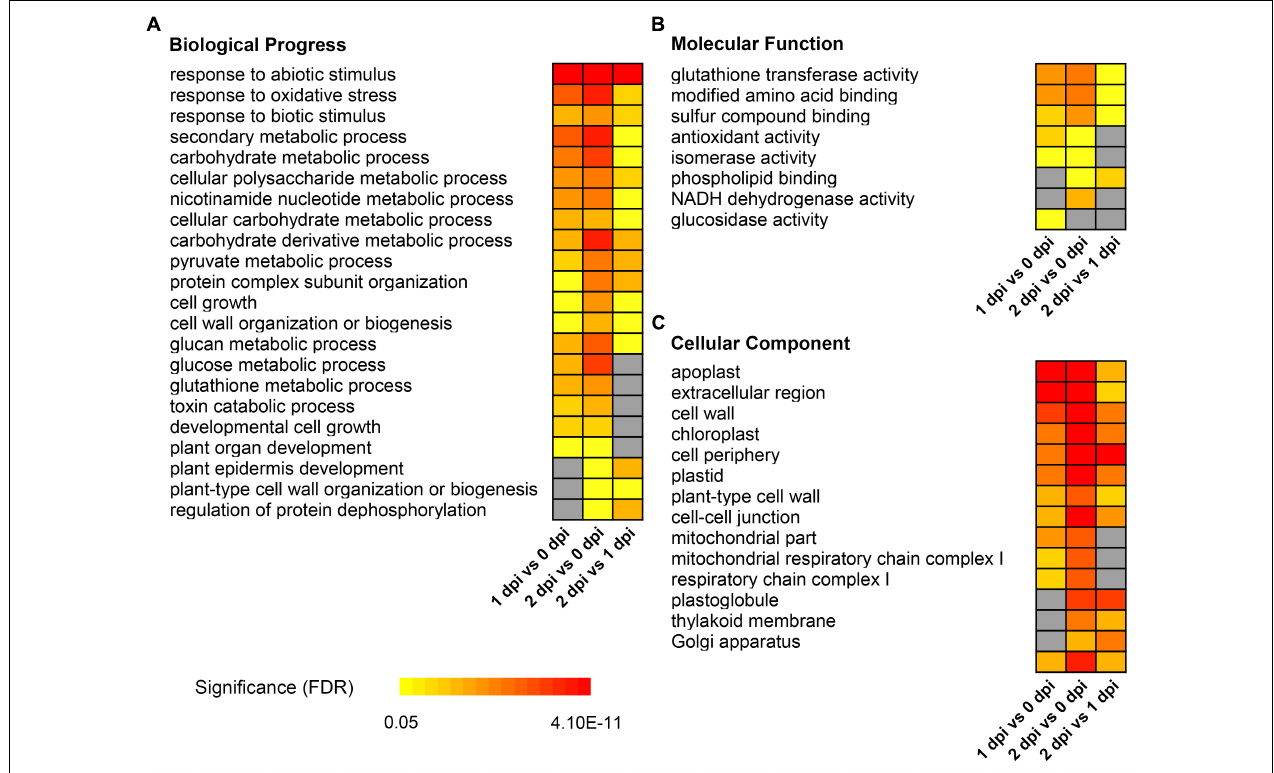
FIGURE 4 | Gene ontology enrichment of down-regulated differentially expressed proteins between 0, 1, and 2 dpi. Enriched GO terms showed in biological progress (A) , molecular function (B) , and cellular component (C) . The colors from yellow to red represent the significance level of the GO terms from low to high. Fisher’s exact test, P -value was adjusted using the Benjamini-Yekutieli method, FDR <